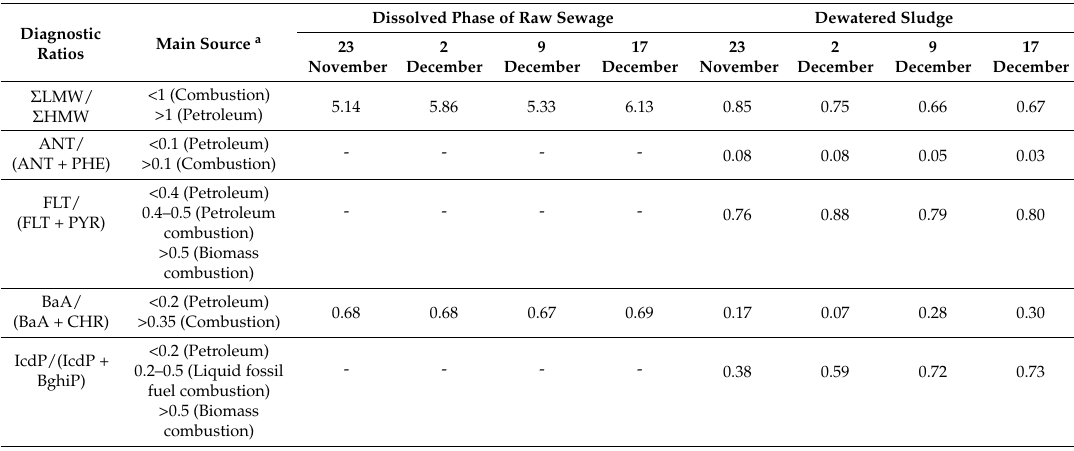
Table 3. Diagnostic ratios of selected PAHs at different